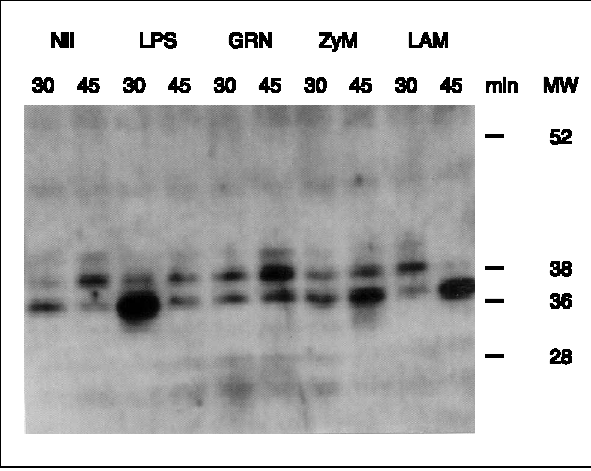
Fig. 4. Tyrosine phosphorylation of CR3-associating proteins. LPS, lipopolysaccharide; GRN, grifolan; ZyM, zymosan; LAM,